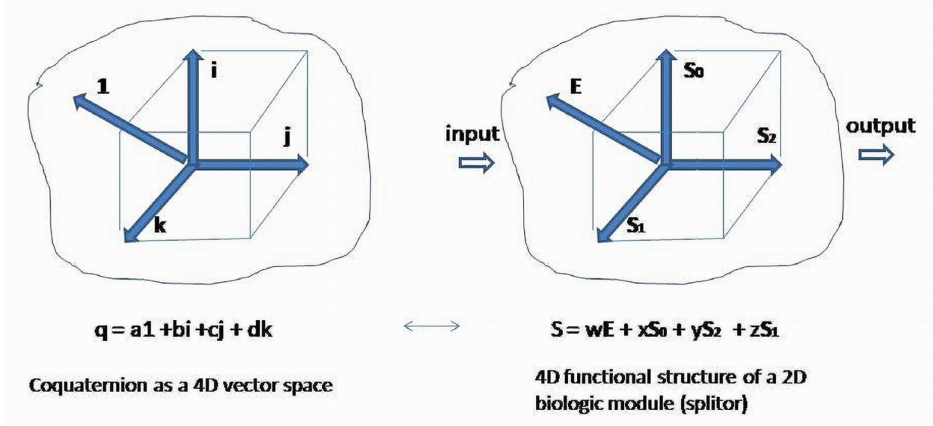
Figure 9. Integration of basis patterns (PNR) in a whole functional structure of a biologic